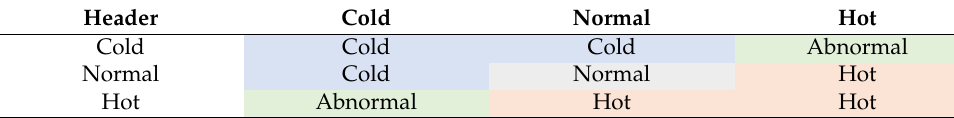
Table 4. Two-factor status grading mark table. Header Cold Normal Hot Cold Cold Cold Abnormal Normal Cold Normal Hot Abnormal Hot